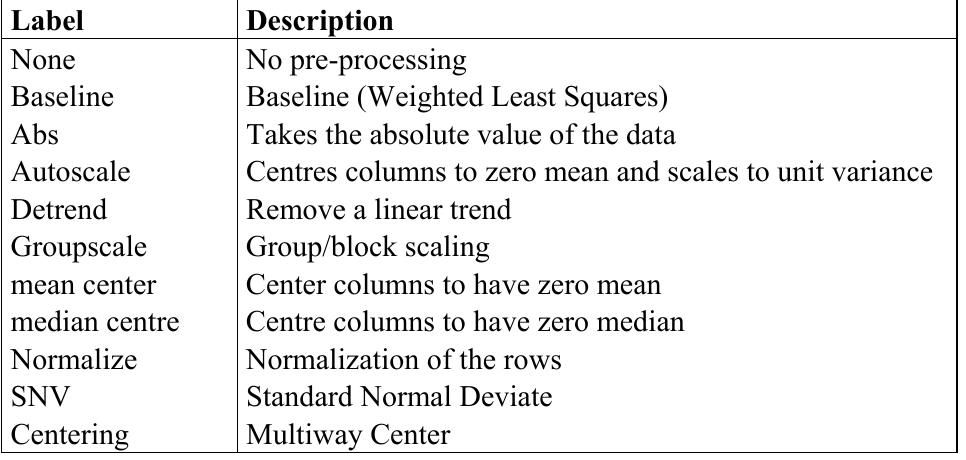
Table 1. List of the different X and Y pre-processing techniques applied in the